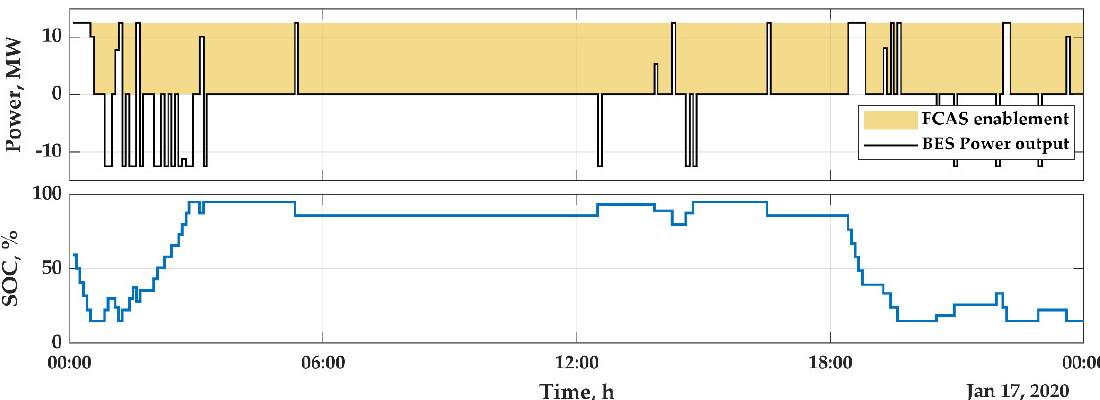
Figure 10. Battery charge and discharge actions and FCAS enablement ( top ) and resulting SOC ( bottom ) under Strategy 2